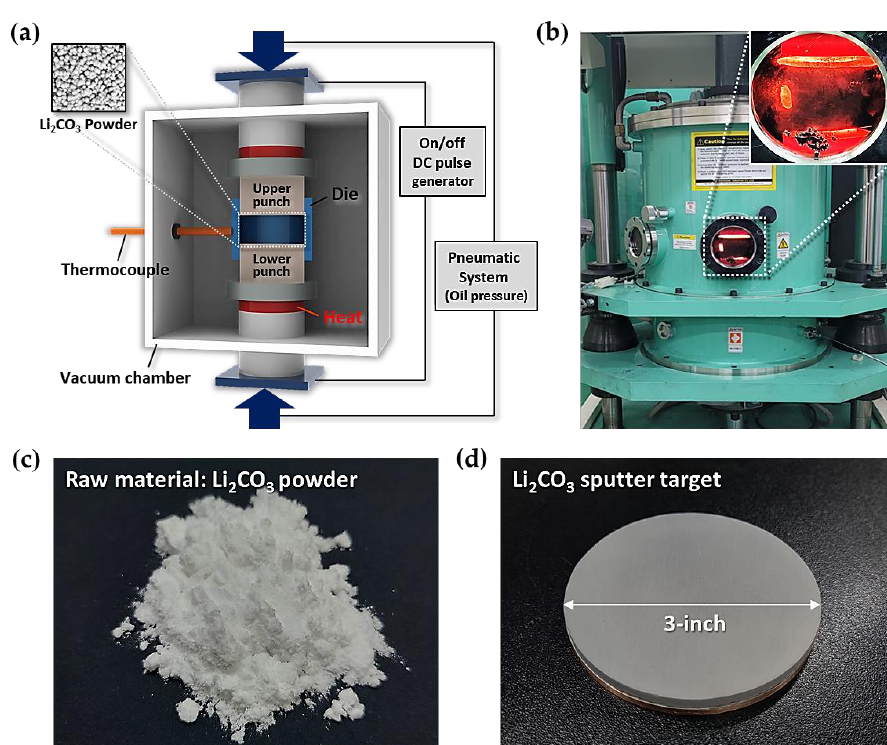
Figure 1. Fabrication of a Li 2 CO 3 sputter target using a Spark Plasma Sintering (SPS) system. ( a ) Schematic image of the SPS system. ( b ) Photographic image of the working SPS system for the fabrication of the Li 2 CO 3 sputter target. ( c ) Li 2 CO 3 raw material (powder). ( d ) Three-inch Li 2 CO 3 sputter target fabricated by the SPS process.